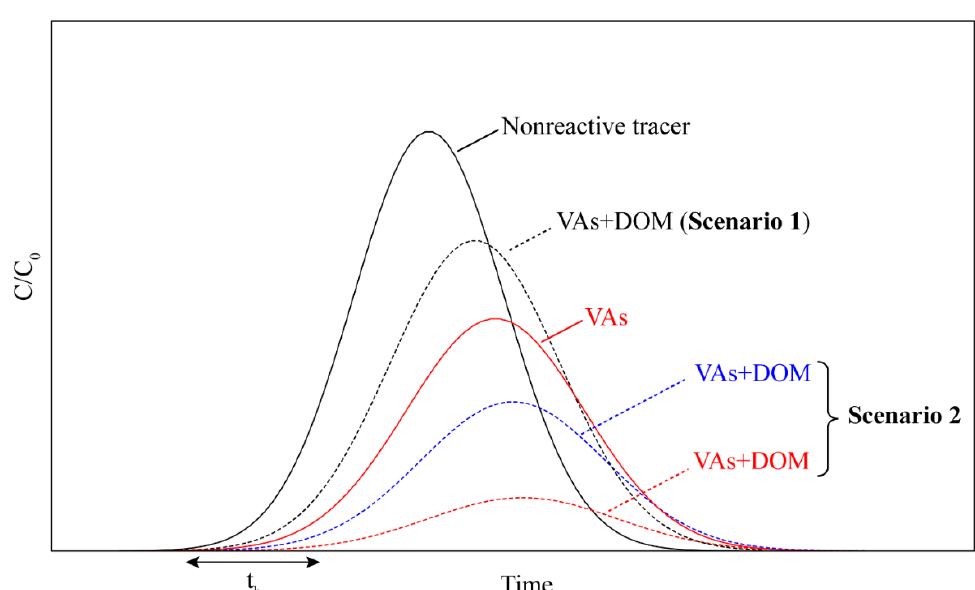
Figure 2. Schematic diagram showing contrasting hypothetical breakthrough curves (BTCs) of nonreactive tracer and veterinary antibiotics (VAs) in the presence and absence of dissolved organic matter (DOM) through homogeneous soil columns. Scenario 1: facilitated transport of VAs through mechanisms such as co-transport, competitive sorption, and colloid facilitated transport. Scenario 2: retardation of VAs through mechanisms such as co-sorption, cumulative sorption, complexation reaction, and straining/pore-entrapment of mobile colloids bearing VAs. t b and C / C 0 are breakthrough time and relative concentration, respectively.